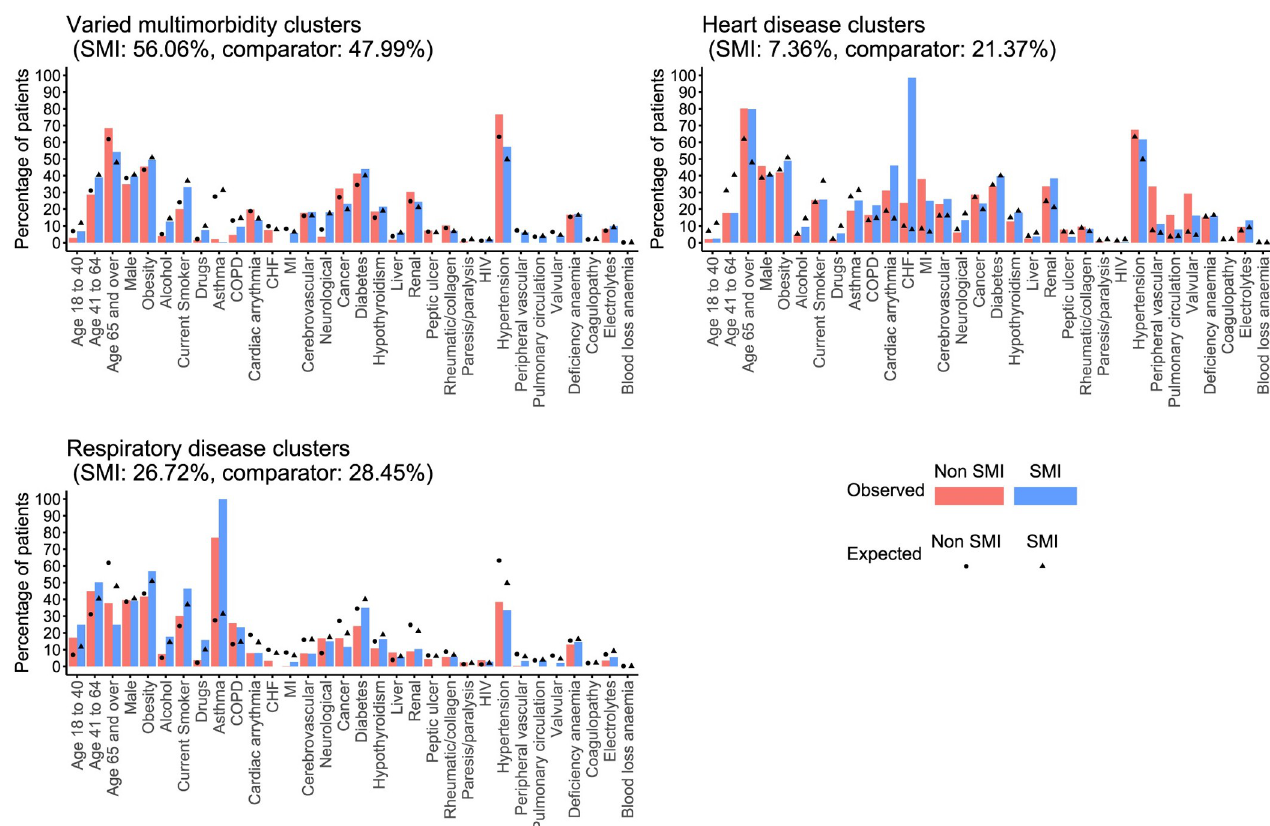
Fig 4. Prevalence of physical health conditions, health risk factors, and demographics in the SMI and comparator cohorts for the 3 most common multimorbidity clusters. � Heart disease in the comparator population is the pooled prevalence across 3 heart disease clusters. CHF, congestive heart failure; COPD, chronic obstructive pulmonary disease; electrolytes, fluid and electrolyte disorders; HIV, human immunodeficiency virus; MI, myocardial infarction.